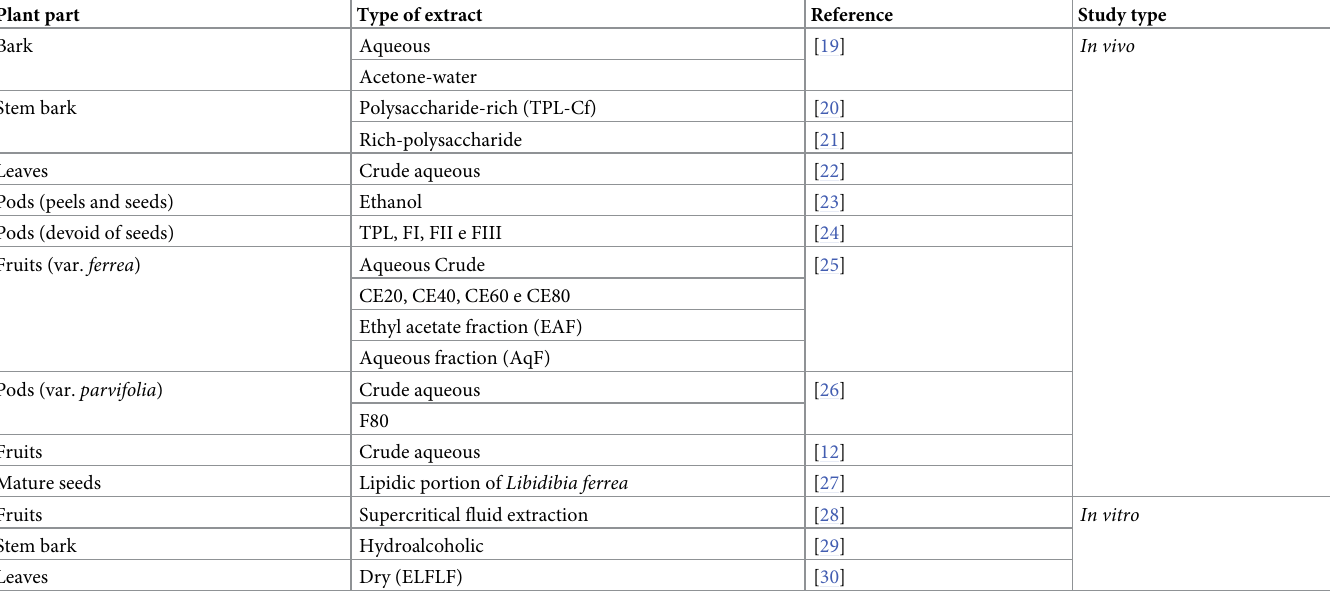
Table 1. Plant part and type of extract from L . ferrea overview used in vivo and in vitro